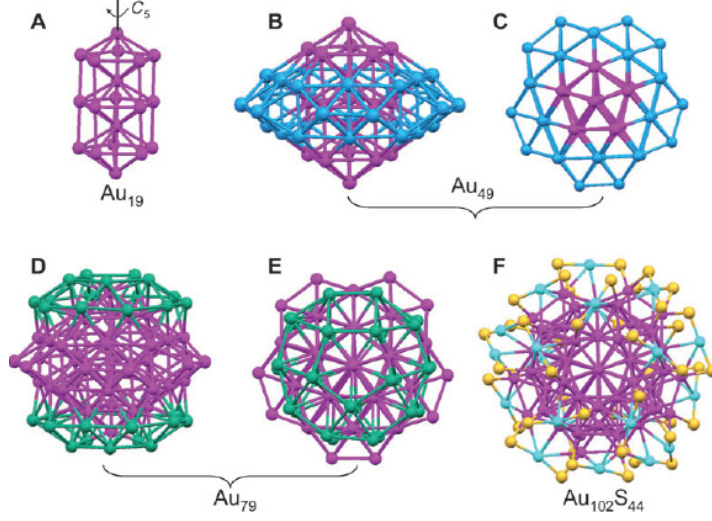
(SR) structure: ( A ) fivefold symmetric 19-atom (Au 102 44 Marks decahedron; ( D , E ) side and top views of Au 49 S (R groups are omitted for clarity) 102 44